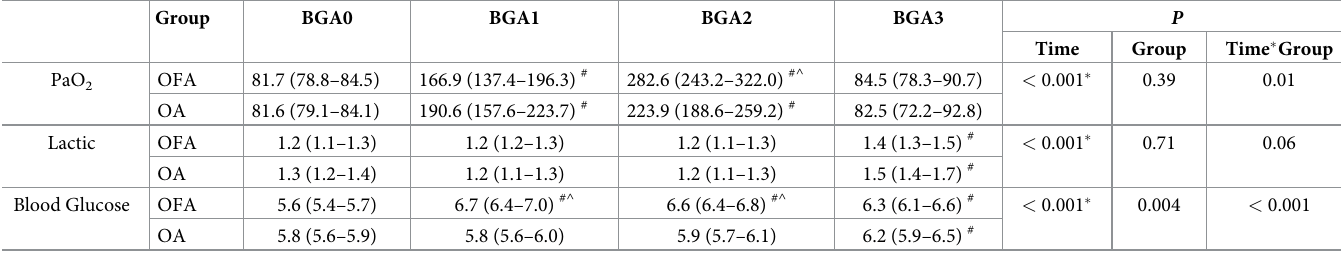
Table 4. Summary of PaO 2 , lactic and blood glucose with repeated measurement (mean, 95% CI).